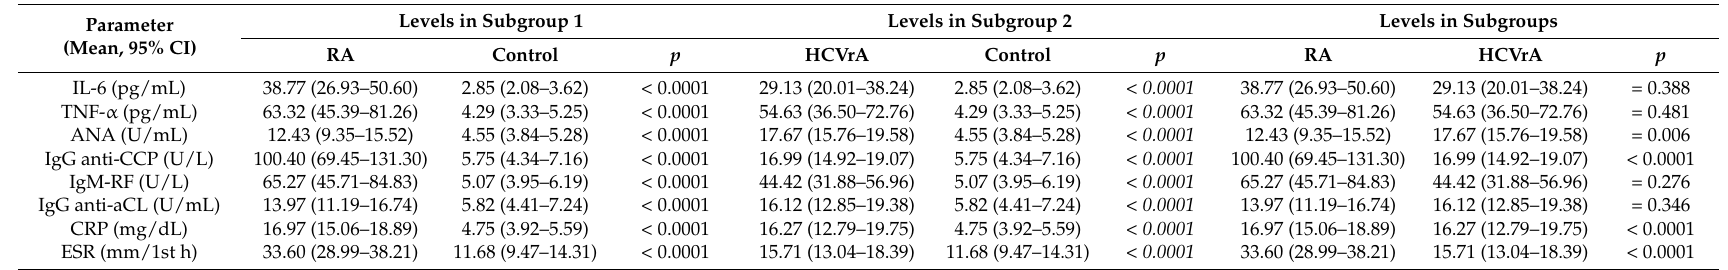
Table 2. IL-6, TNF- α and auto-antibodies (antinuclear auto-antibodies—ANA, anti–cyclic citrullinated peptide antibodies IgG isotype, IgG anti-CCP, anti-cardiolipin